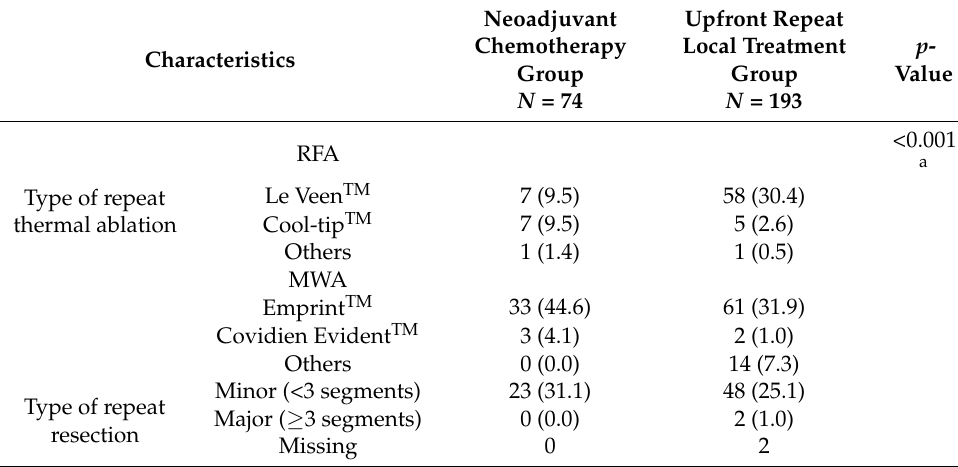
Table 3. Treatment characteristics per tumor of repeat local treatment.